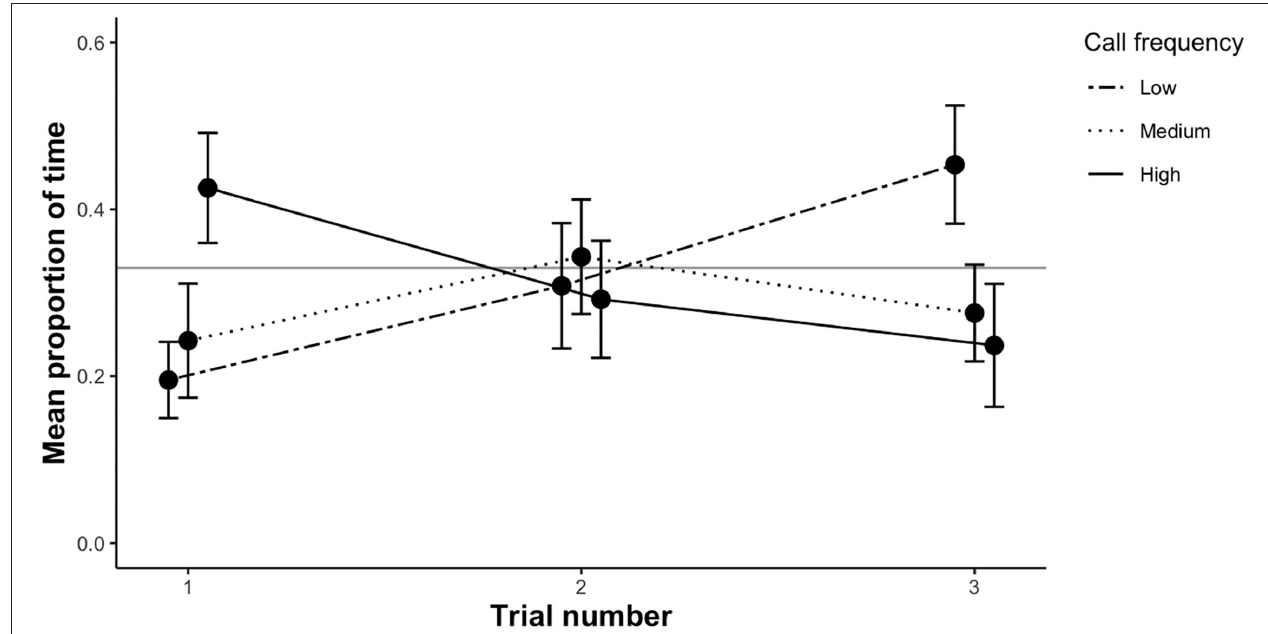
FIGURE 3 | The mean proportion of time ( ± SE) female P. corroboree spent in each of the three call zones (low, medium and high) during each of the three trial rounds. Sample size for each trial as follows—trial 1: n = 40, trial 2: n = 18, trial 3: n = 18. The proportion of time spent in each call zone was compared to an expected value of 0.33, represented by the gray horizontal line.